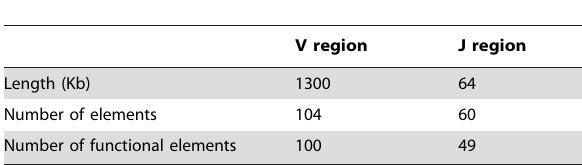
Table 1. TRA/TRD locus characterization.